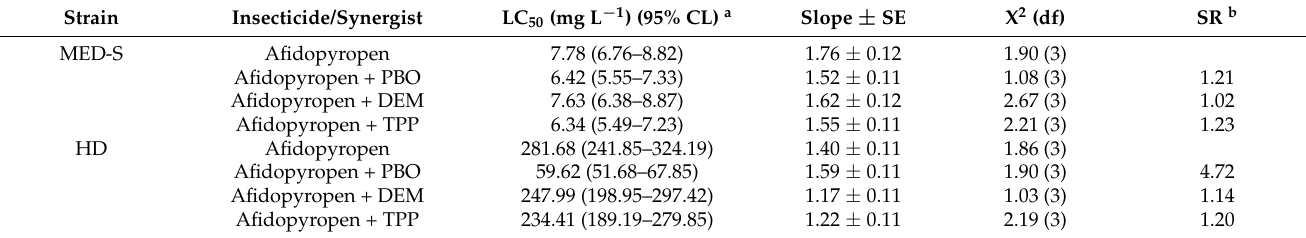
Table 4. Synergistic effects on afidopyropen toxicity in the susceptible MED-S and afidopyropen- resistant HD strains of B. tabaci .